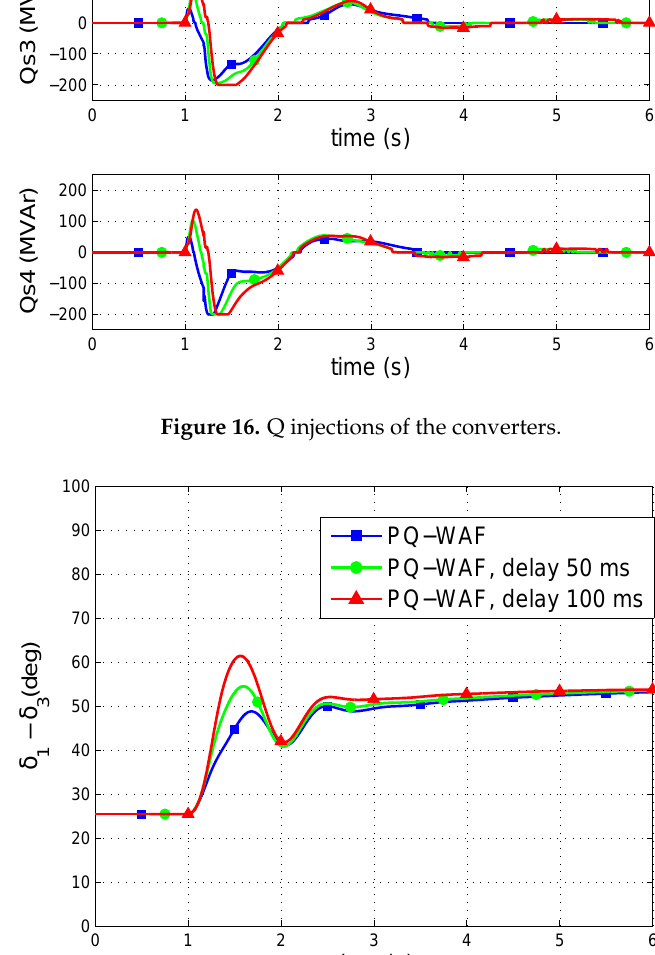
Figure 17. Generator angle